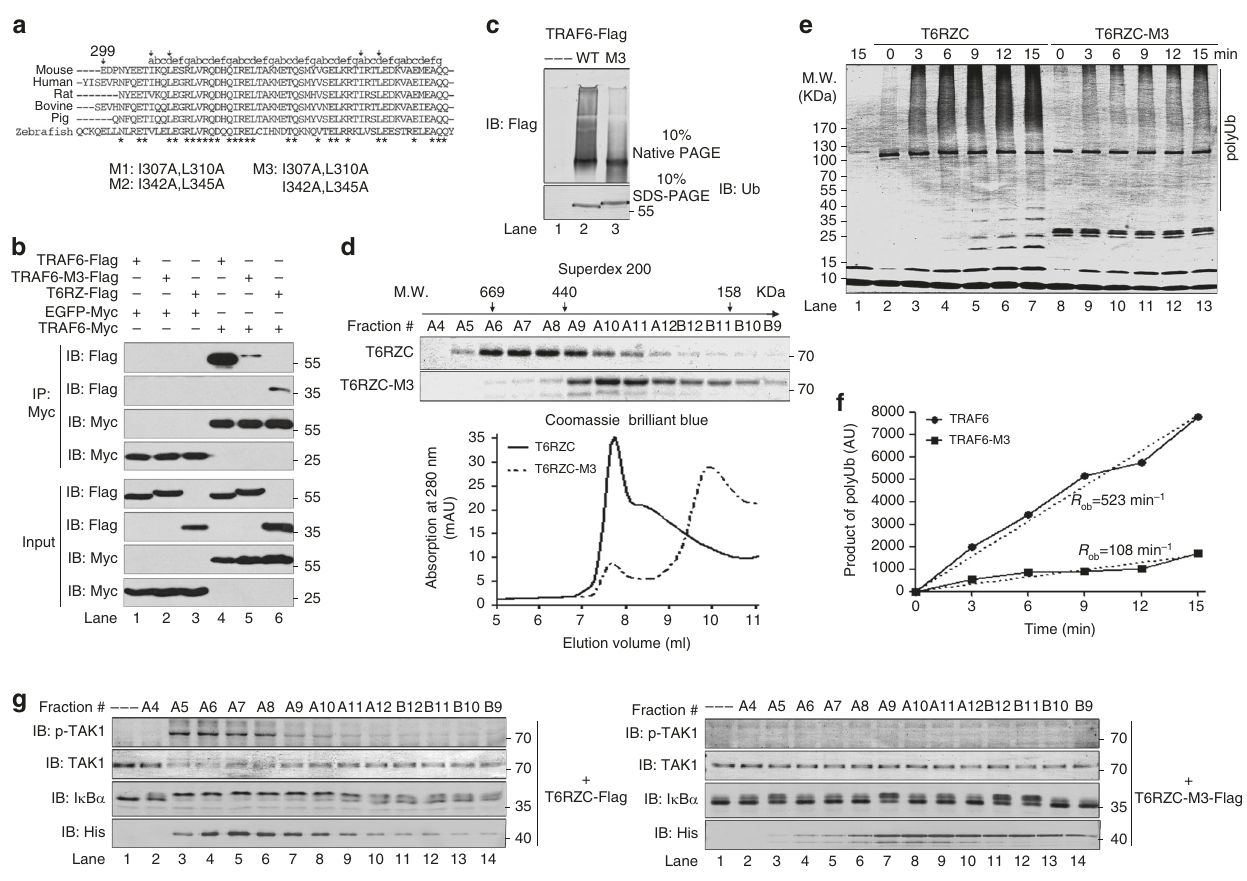
Fig. 5 CC domain mediates TRAF6 intermolecular interaction and oligomerization. a Amino acid sequence alignment of TRAF6 CC domains from different species. The heptad repeats are denoted with “ a-b-c-d-e-f-g ” . Arrows indicate the mutation residues used in the study. b CC domain mediates TRAF6 self- association. Flag-tagged TRAF6, mutant M3, or T6RZ were co-transfected with Myc-tagged TRAF6 or with Myc-tagged EGFP into HEK293T cells and subjected to immunoprecipitation with anti-Myc antibodies. The immunoprecipitated complexes (upper panels) and cell lysates (down panels) were immunoblotted with the indicated antibodies. c CC domain mediates TRAF6 oligomerization. TRAF6-Flag and TRAF6-M3-Flag were expressed in HEK 293T cells and puri fi ed using anti-Flag M2 magnetic beads. The eluted proteins were analyzed by 10% native gel. d CC domain mediates TRAF6 oligomerization. T6RZC and T6RZC-M3 were puri fi ed from Sf9 cells and separated by size-exclusion column Superdex 200. Aliquots from each fraction were separated by 10% SDS-PAGE and detected by Coomassie blue staining. Superimposed gel fi ltration pro fi les of T6RZC and T6RZC-M3 are shown below. e , f Disruption of CC oligomerization impairs polyUb chain synthesis. Time-course analysis of polyUb chain synthesis was performed to compare T6RZC and T6RZC-M3. Time-dependent accumulation of polyUb chains was shown in e and quanti fi ed in f . R ob , arbitrary observed rate of polyUb assembly. g Only the high molecular size TRAF6 can activate TAK1 and IKK. Aliquots from d were subjected to in vitro IKK activation assay. Activation of TAK1 and IKK was determined with the indicated